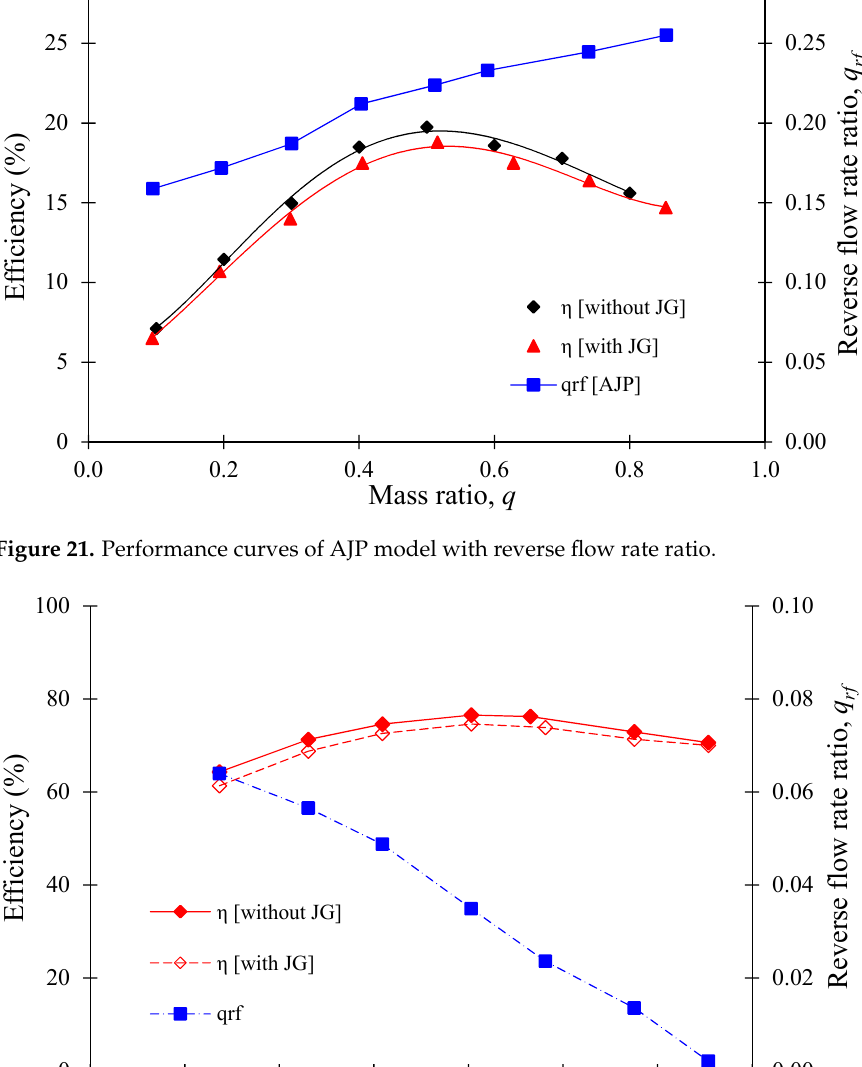
Figure 20. Velocity vector distribution in the SCP model with J-Groove at Q/Q BEP = 1.00.